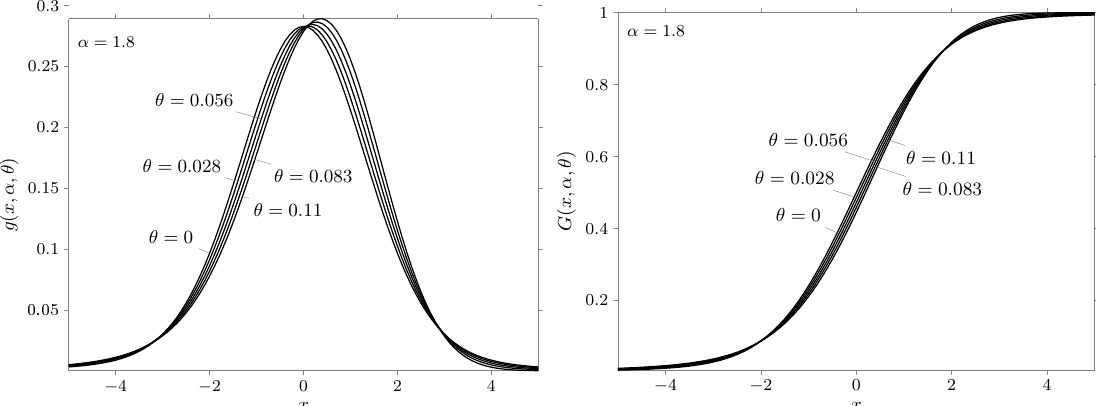
Figure 14. The probability density function g ( x , α , θ ) ( on the left ) and cumulative distribution function G ( x , α , θ ) ( on the right ) of a standard strictly stable law with α = 1.8 and specified values θ